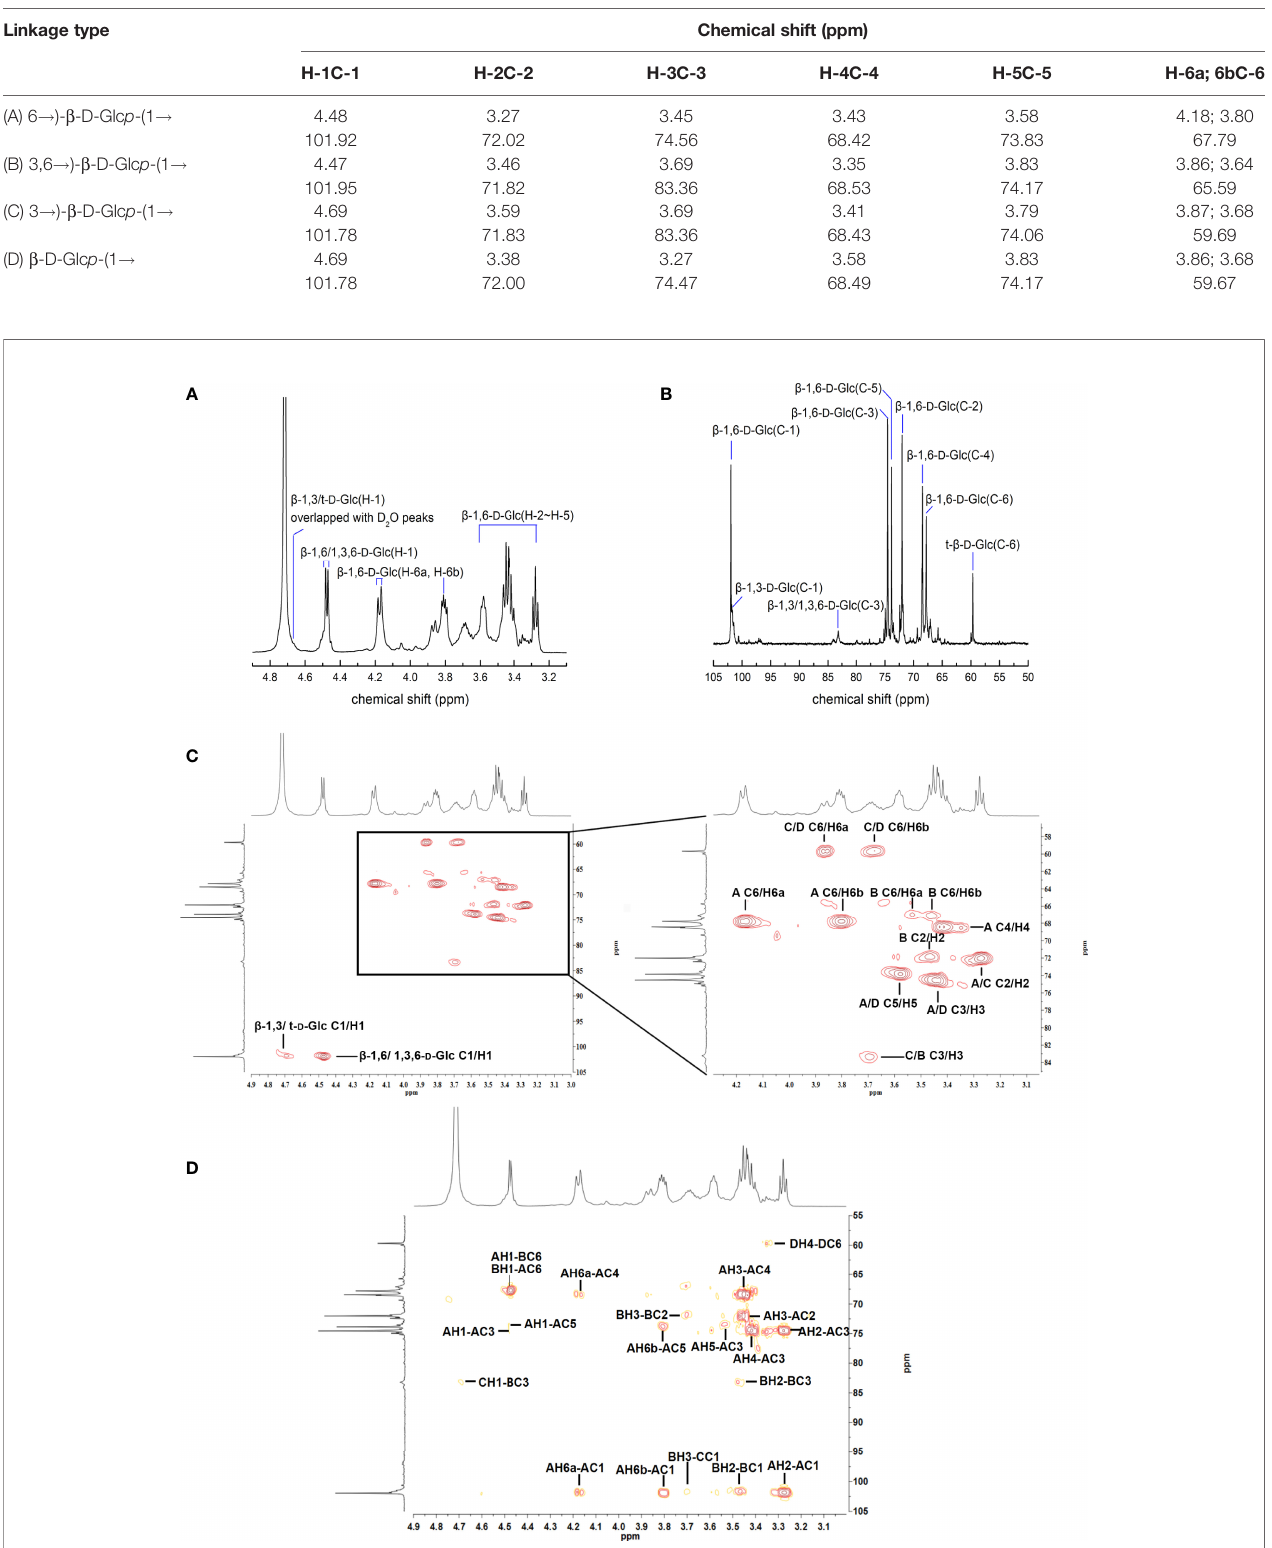
TABLE 3 | HSQC spectral assignments of